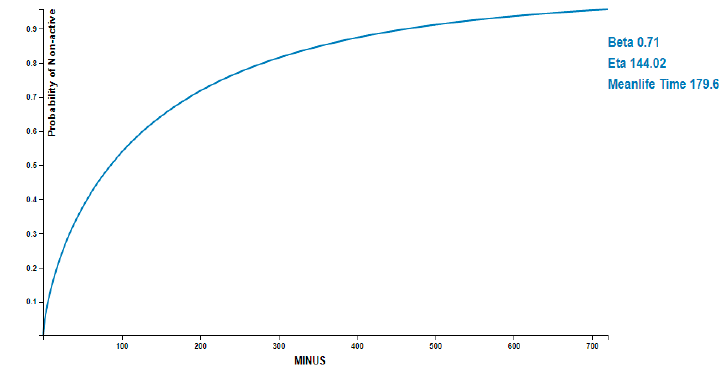
Figure 3. Result of the fitting curve of Weibull distribution .